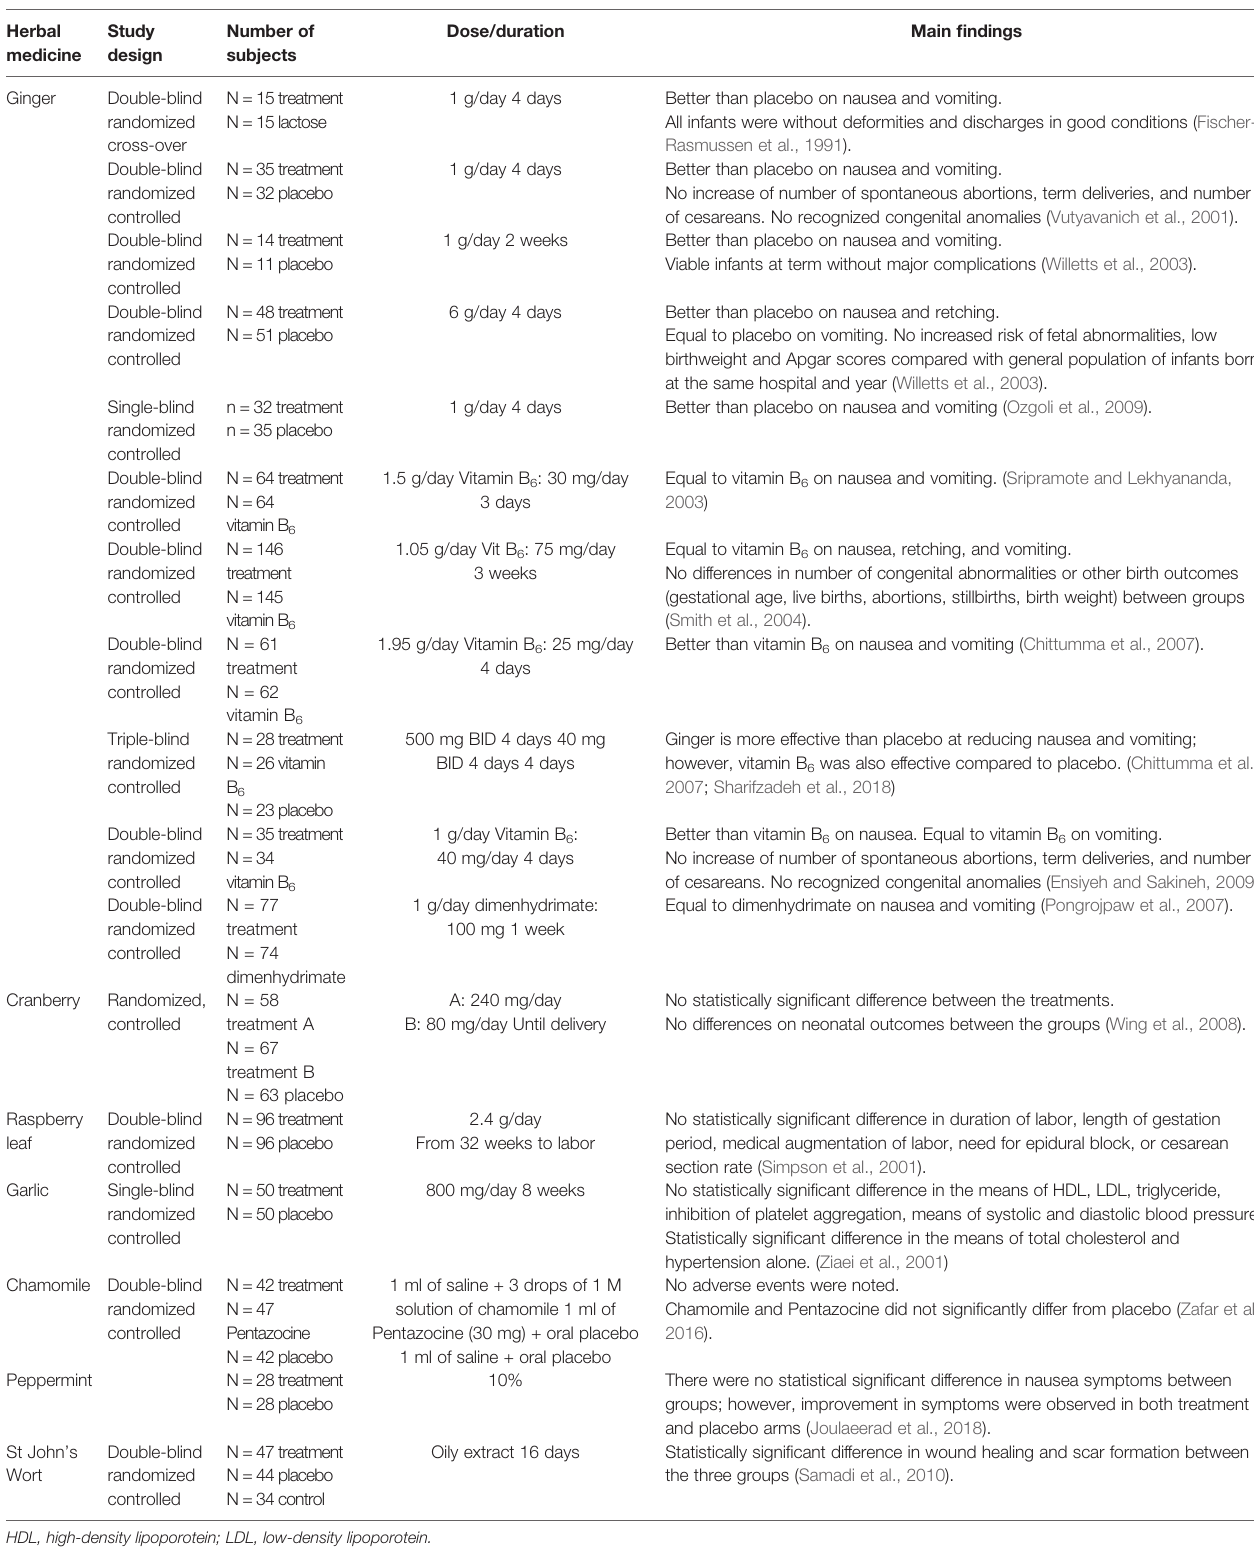
TABLE 2 | Clinical trials on safety and/or ef fi cacy of herbal products in pregnancy. Herbal medicine